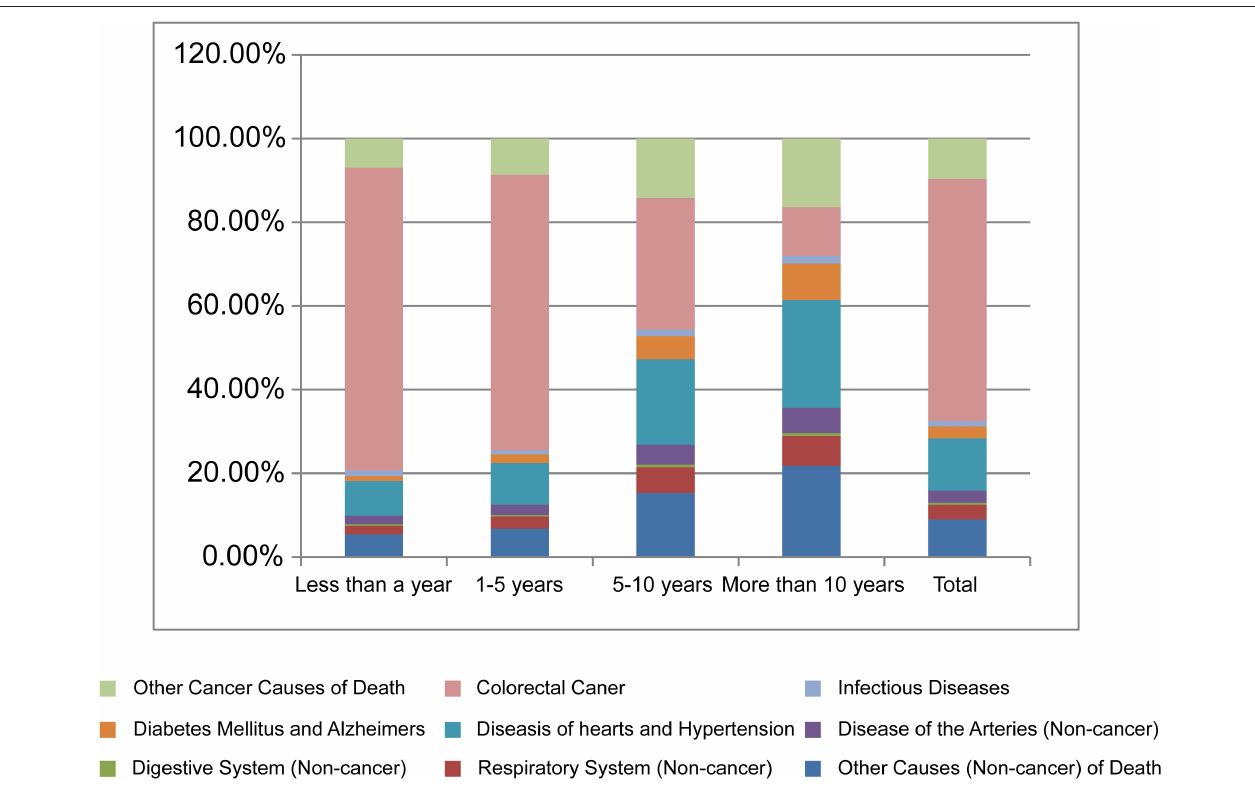
FIGURE 1 | Causes of death in each latency period following CRC